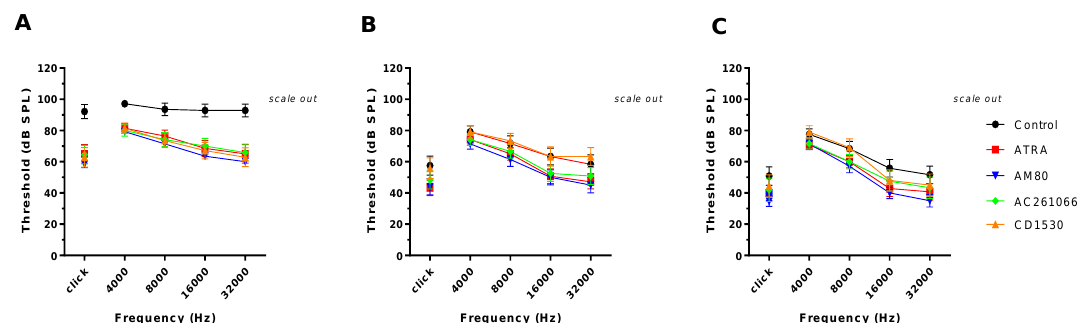
Figure 2. Click-evoked auditory brainstem response (ABR) thresholds immediately after noise exposure at Day 1 ( A ), 3 ( B ) and 7 ( C ). The hearing thresholds were significantly lower in groups treated with all-trans retinoic acid (ATRA) and all selective retinoic acid receptor (RAR) agonists than in the control group at every frequency, especially high frequency at Day 1( A ). ( p < 0.05) ABR thresholds began to recover in all groups at Day 3 and Day 7.